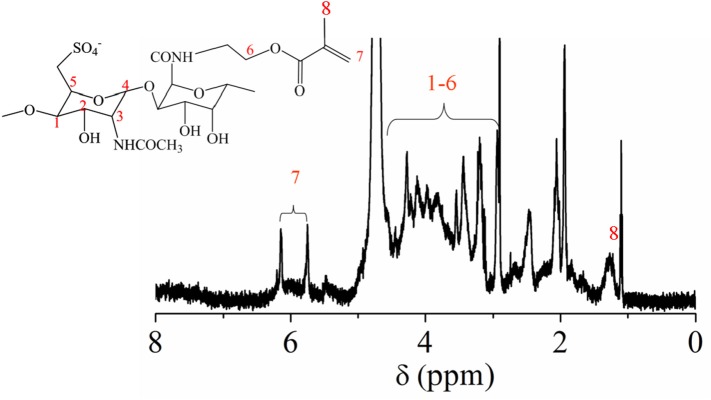
1H NMR spectrum of HEP-AMA.